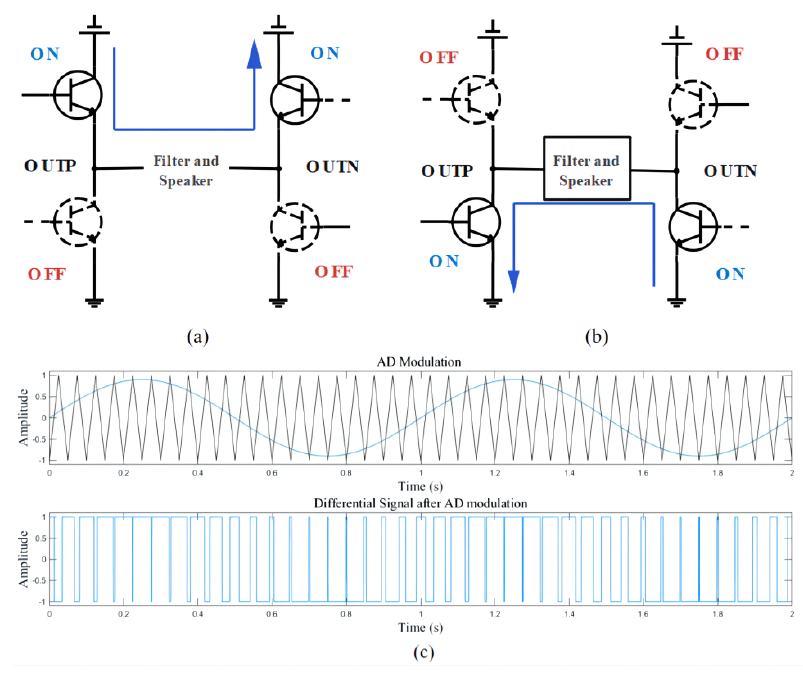
Figure 7. An AD modulation topology ( a , b ), and AD modulation waveforms ( c ). The manipulation of BD modulation is more involved than that of AD modulation.